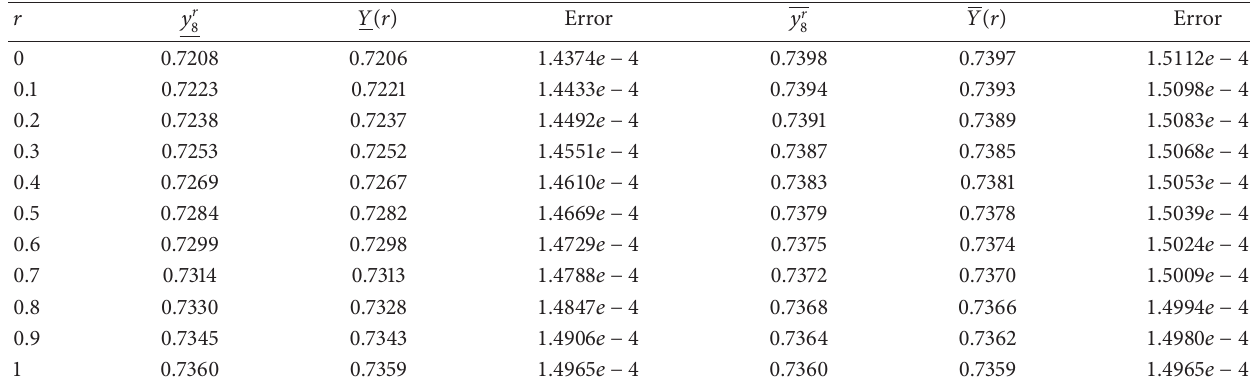
Table 5: The result of the proposed method for Example 62 with 𝛼 = 0.85 and 𝑚 = 8